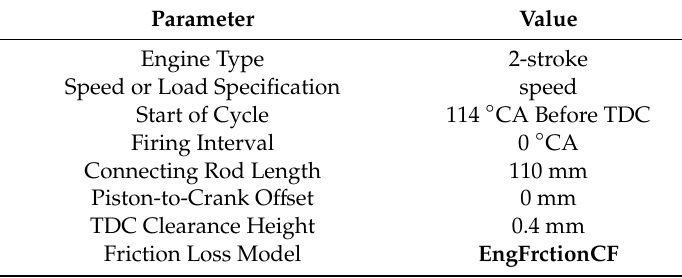
Table 9. Parameter settings of the simulation module of